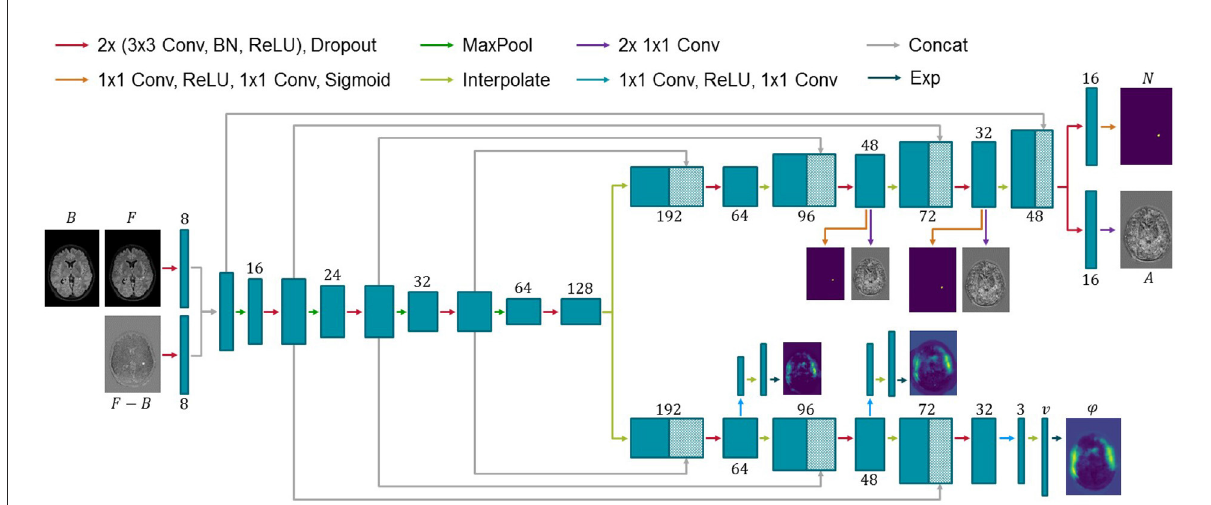
FIGURE1 Architecture of the proposed network for new MS lesions modeling. Input to the network are baseline and follow-up MR images and their subtraction image. Two decoders generate a diffeomorphic deformation field ϕ for registration of baseline to follow-up and a segmentation N of new lesions together with appearance offsets A . Numbers below or above the blue boxes indicate the number of feature maps. Since the max pooling does not change the number of features, we omit the numbers before max pooling for visualization